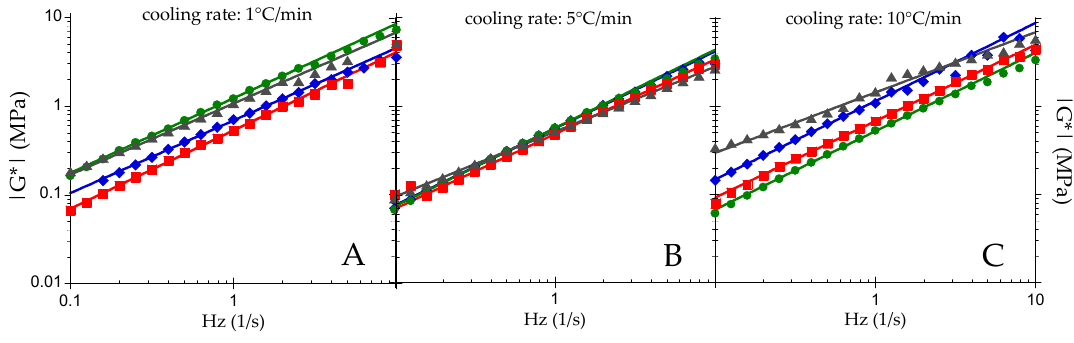
Figure 2. Complex modulus |G*| vs frequency determined at 25 °C for neat bitumen (diamonds), and bitumens modified by addition of 2% P2KA (circles), LCS (squares) and PPA (triangles), respectively, after the specimens were subjected to different thermal treatment: ( A ) 1 °C/min, ( B ) 5 °C/min and ( C ) 10 °C/min. Solid lines represent the best non-linear fits according to the power law of Equation (3), whose fitting parameters z and A have been listed in Tables 2 and 3, respectively.